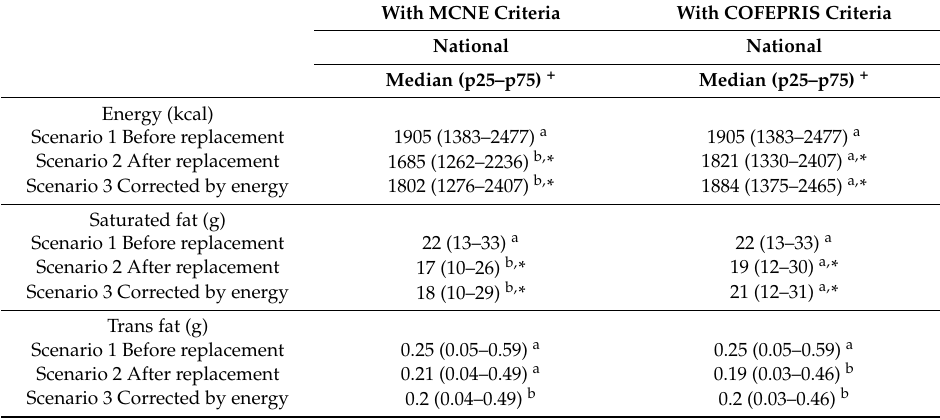
Table 2. Energy and nutrient intake before and after the simulation of food replacement in the diet of the Mexican adult population, with MCNE criteria and COFEPRIS criteria Mexico, ENSANUT